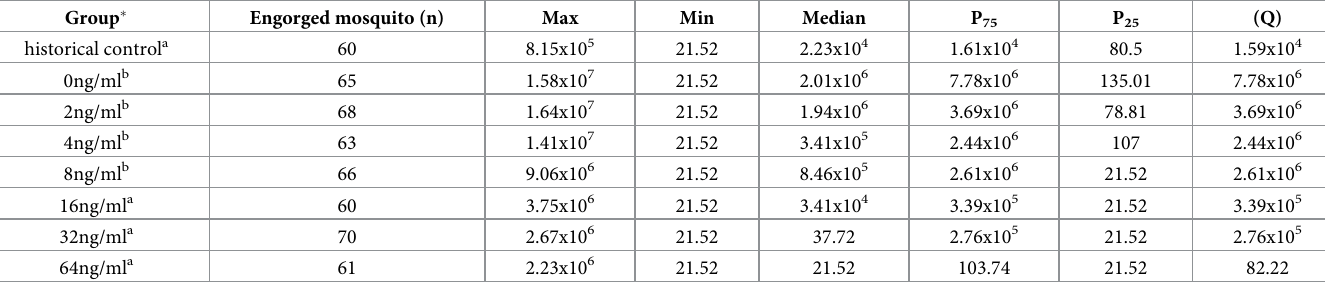
Table 2. Pair-wise differences of DENV-2 RNA concentrations (copies/ml) among the eight groups. Group � Engorged mosquito (n) historical control